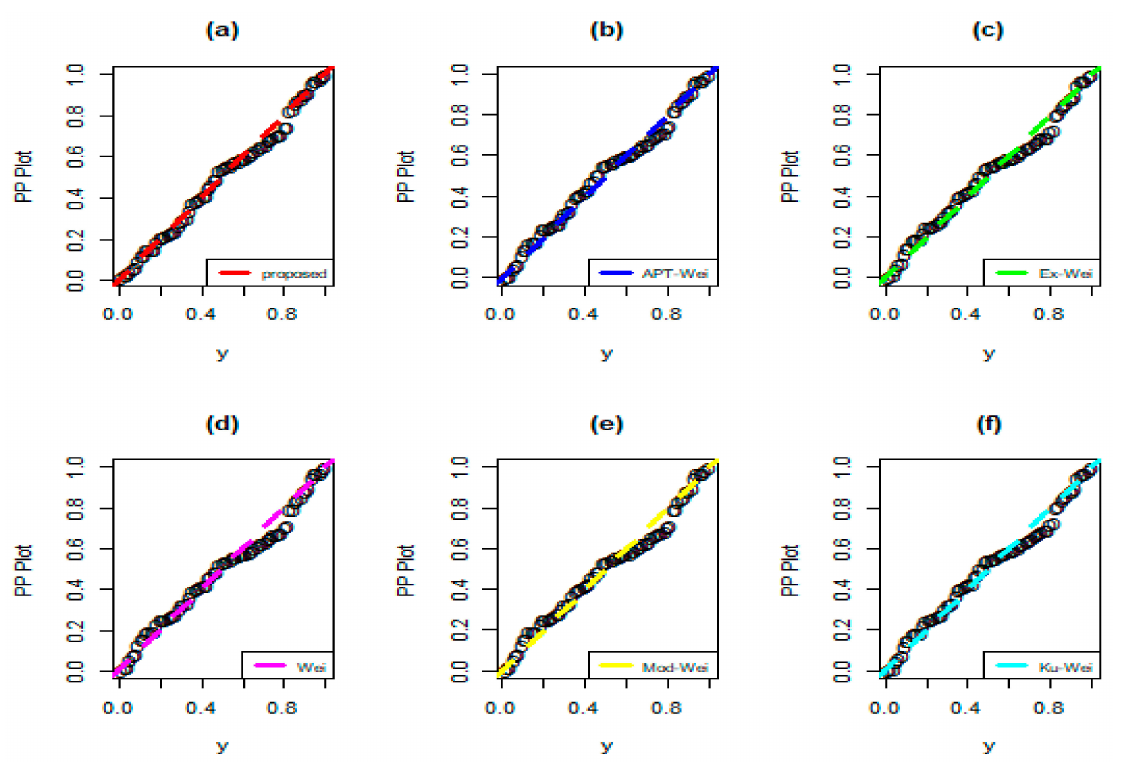
Figure 17. Probability–probability (PP) plots of ( a ) NMEPA-Wei, ( b ) APT-Wei, ( c ) Ex-Wei, ( d ) Wei, ( e ) Mod-Wei, and ( f ) Ku-Wei for Data 2.